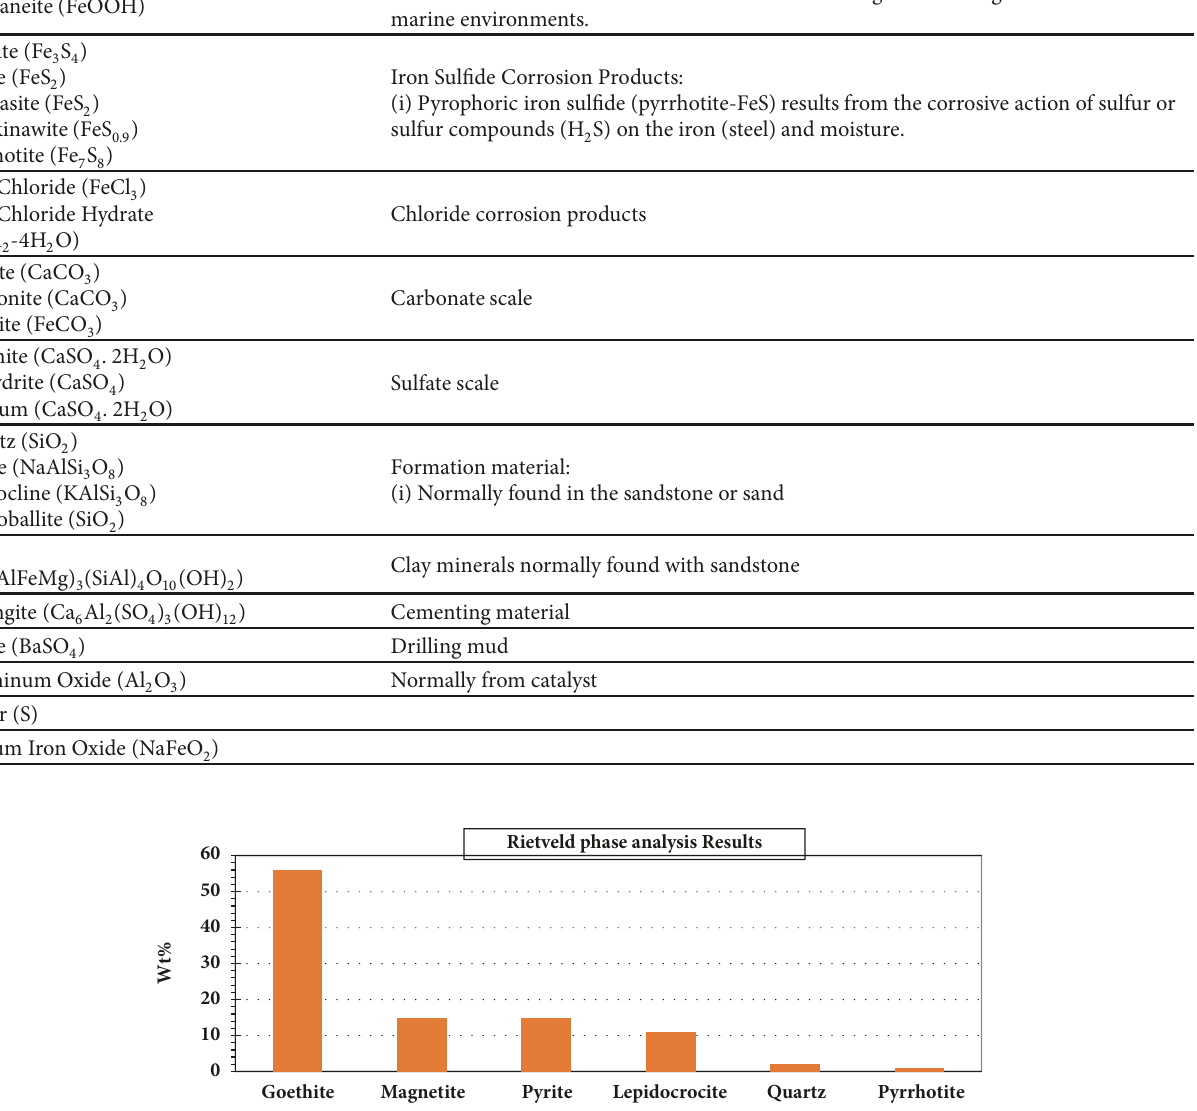
Figure 1: Rietveld phase analysis results of inorganic materials (insoluble part)